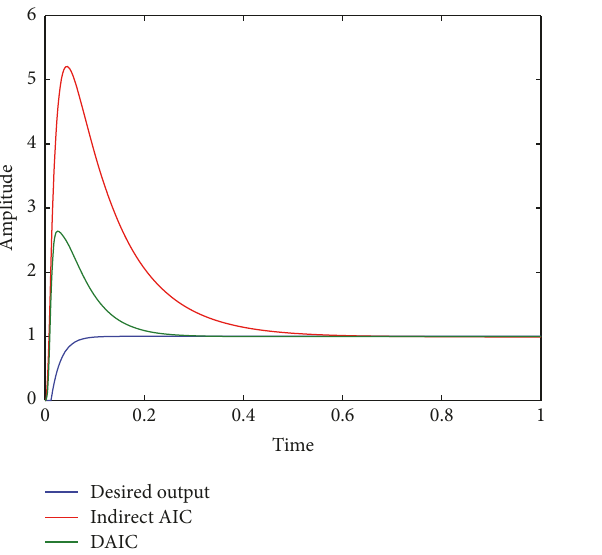
Figure 7: Tracking error: first 1sec.